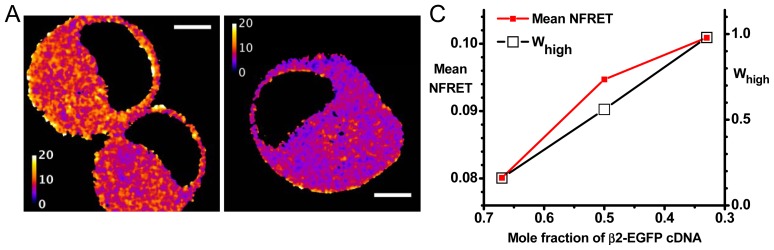
Data from NFRET measurements with biased transfection ratios. (A) NFRET images for representative cells transfected with 0.5 mole fraction plasmid ratios of β2-EGFP and α4-mCherry. The lookup table runs from 0 to 0.2 fractional NFRET. Scale bars, 5 μm; (B) NFRET data for transfection with 0.67, 0.5, and 0.33 mole fraction plasmid ratios of β2-EGFP. For each graph, the heavy line is the measured histogram; this is generally obscured by the blue curve which sums the Gaussians fitted to the high and low NFRET components (dashed lines). The computed fractional area of high NFRET pixels (Whigh) is shown in each case; (C) Average NFRET and Whigh
vs. mole fraction of β2-EGFP cDNA transfected, from the data in (B). The left y-axis gives mean NFRET. The standard errors of the mean are much smaller than the size of symbols, because each sample had > 106 pixels. The right y-axis is Whigh; (D) Plots of the CV of the NFRET pixel distribution (y-axis) vs. the expression level (x-axis). Each point corresponds to a cell. Expression level is quantified as NFRET normalization, the mean of
(IeGFPImcherry) for each cell. The fitted curves have the form,
y=b(a+x).